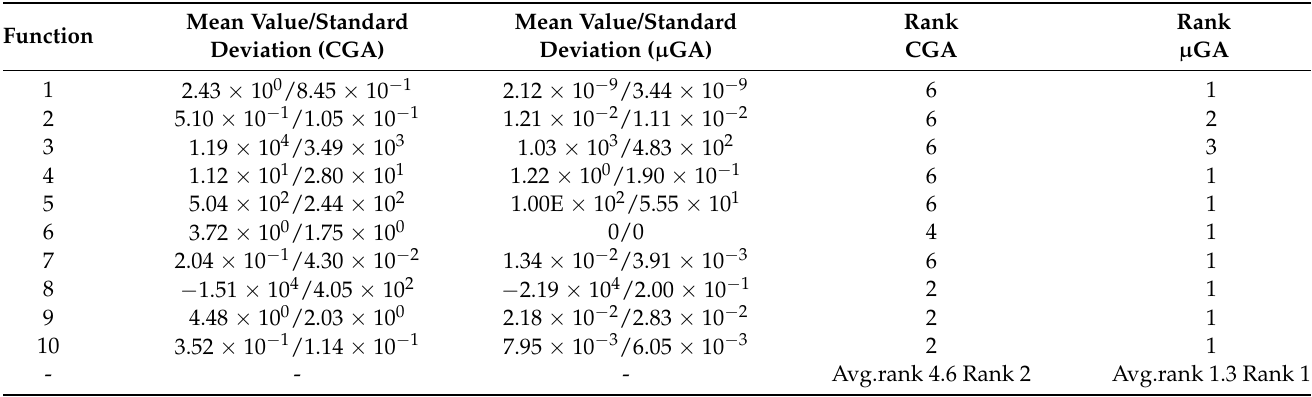
Figure 15. Convergence graphs of the benchmark functions. Table 9. Benchmark functions’